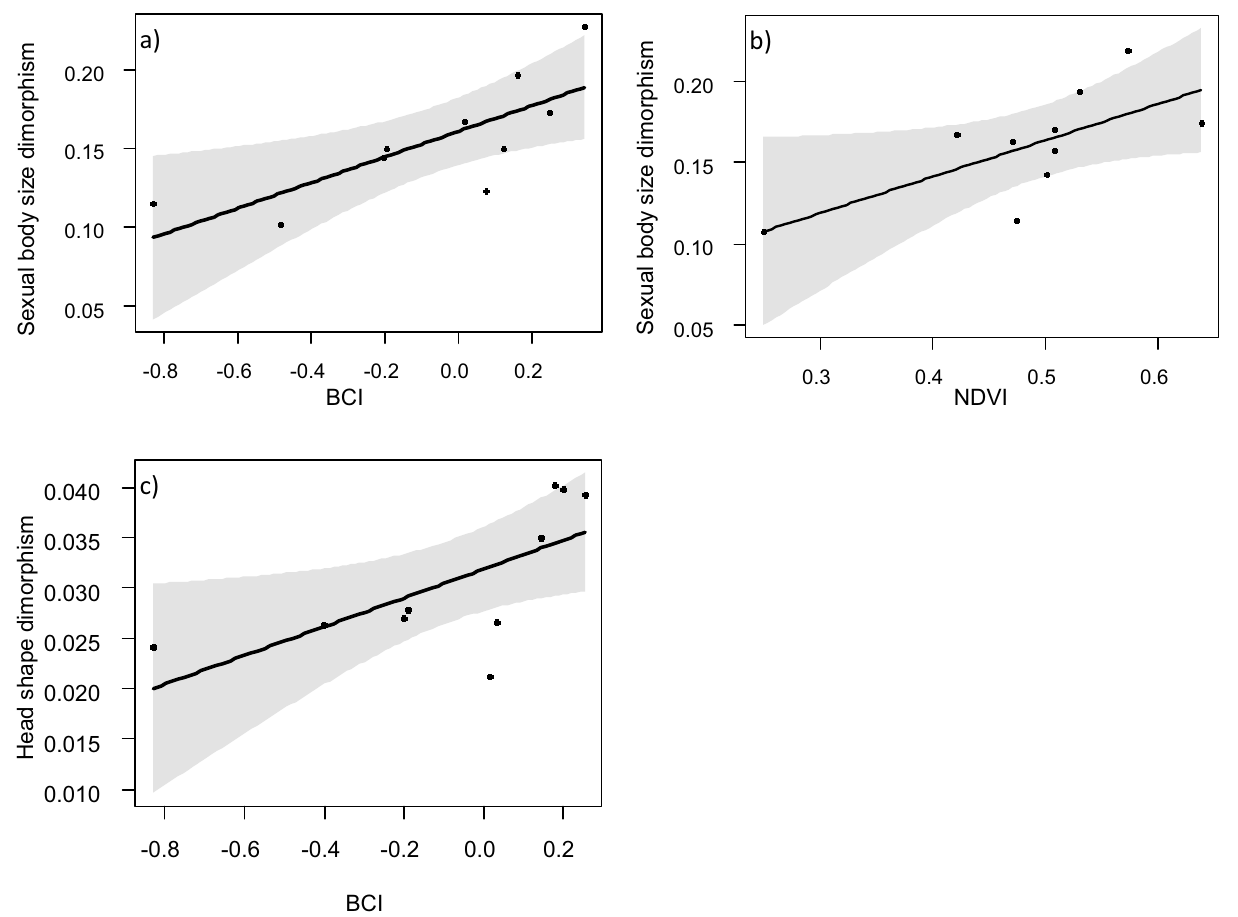
Figure 4. Conditional plots showing the relationship between sexual dimorphism and the environmental drivers included in the best AICc models at the island scale (N = 10). Sexual dimorphism: ( a , b ) body size dimorphism, ( c ) head shape dimorphism; drivers: ( a - c ) BCI, ( b ) NDVI. Black line: regression line, grey shaded area: 95% confidence